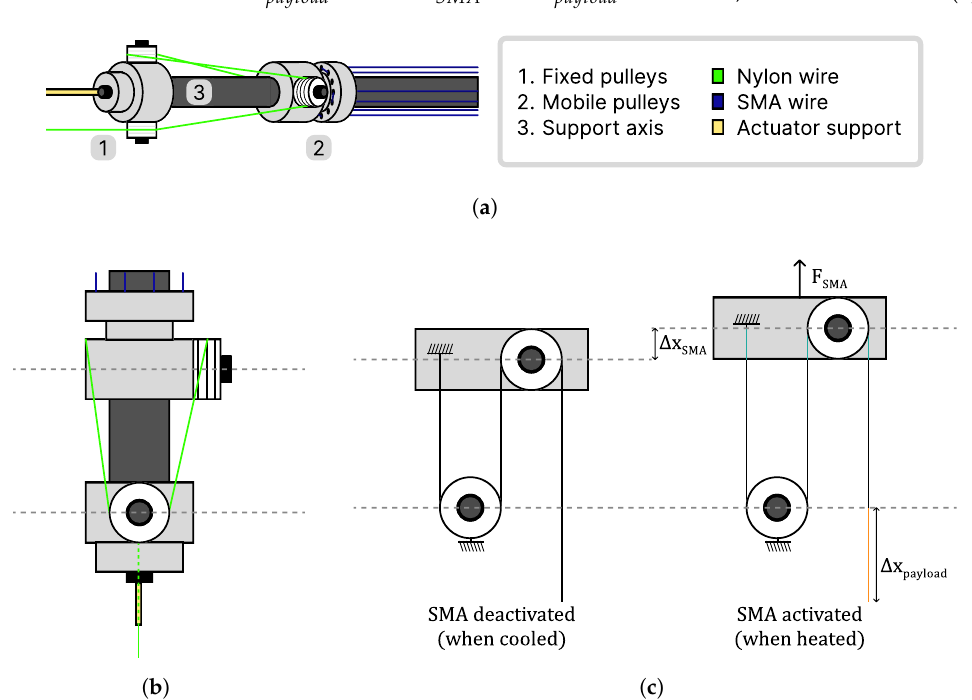
Figure 1. Scheme of the hoist’s working principle. The displacement produced in the mobile pulleys is multiplied in the payload. ( a ) A diagram of the hoist and its integration into the developed actuator. ( b ) Schematic top view of the hoist. ( c ) Simplified schematic of the hoist for displacement